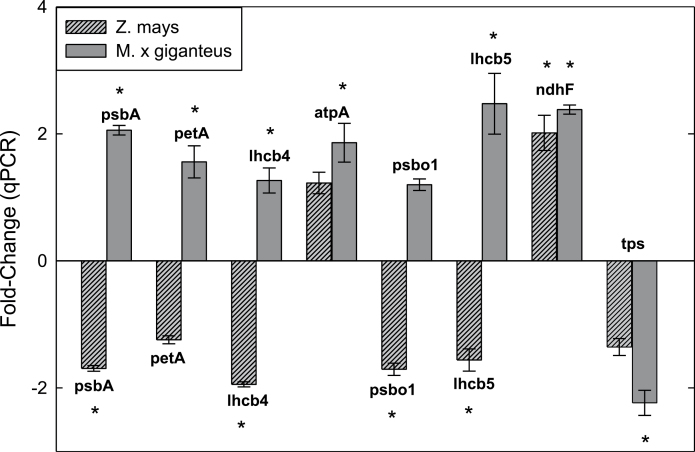
Comparison of gene expression between M. × giganteus and Z. mays after 14 days of chilling (14 °C) versus control (25 °C). qPCR-tested transcripts included five transcripts found to be up- or downregulated on the microarray (atpA, ATP synthase alpha subunit; psbo1, oxygen-evolving enhancer protein 1; lhcb5, chlorophyll a/b-binding protein CP26; ndhF, NADH dehydrogenase F; and tps, terpene synthase), and three additional light reaction transcripts: psbA, D1; petA, cytochrome f; and lhcb4, chlorophyll a/b-binding protein CP29). Results were normalized against the reference gene act and the ΔΔCT method was used to calculate fold-change. Error bars represent the standard error of the mean of all biological replicates (n=4). Asterisks indicate significant differential expression between control and chilling (α≤ 0.05).